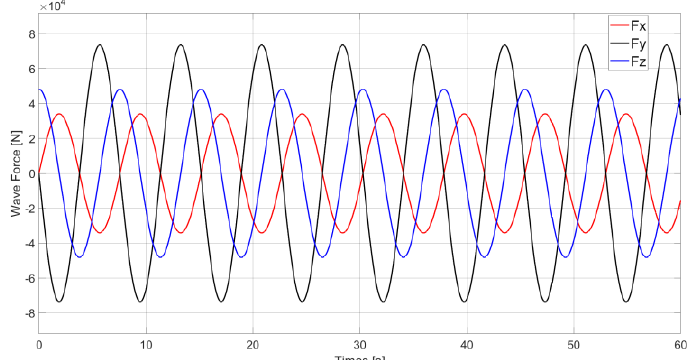
Figure 8. Wave force.